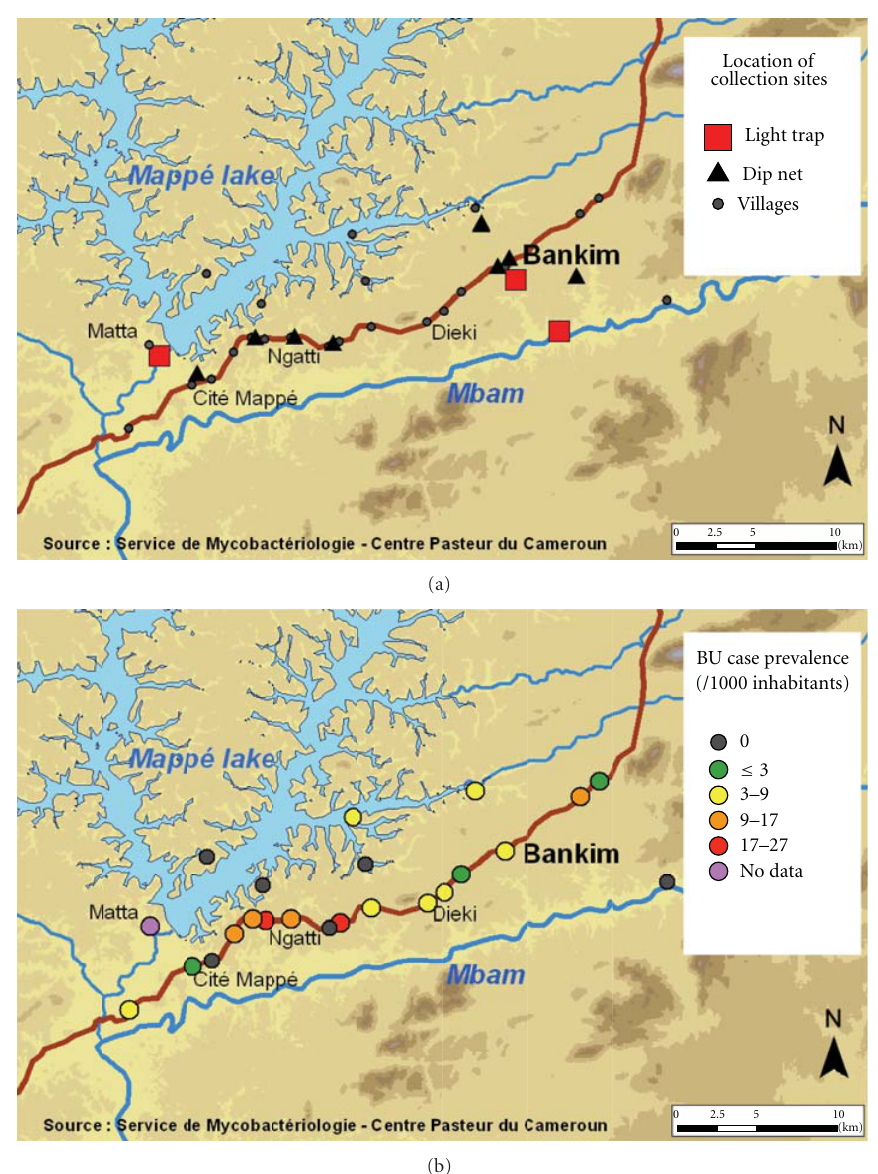
Figure 1: (a) Study site; (b) Buruli ulcer case prevalence per